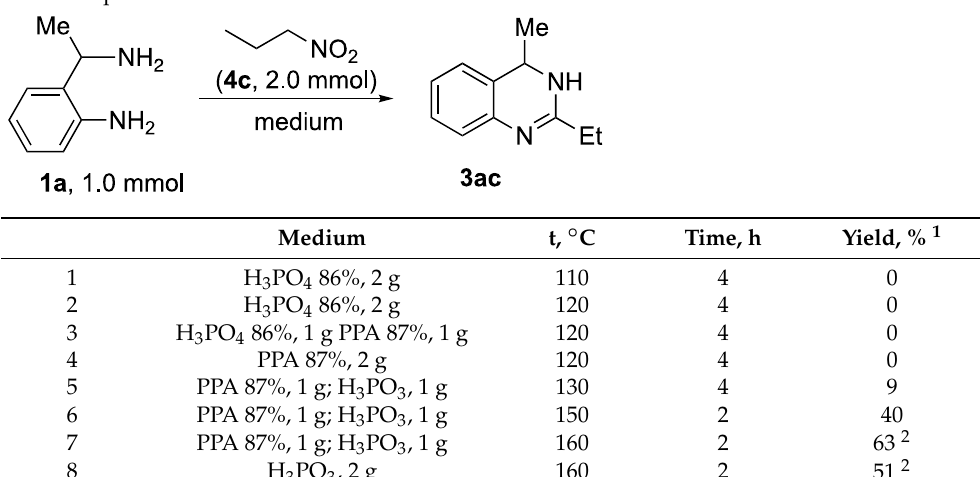
Table 1. Optimization of reaction conditions for annulation.